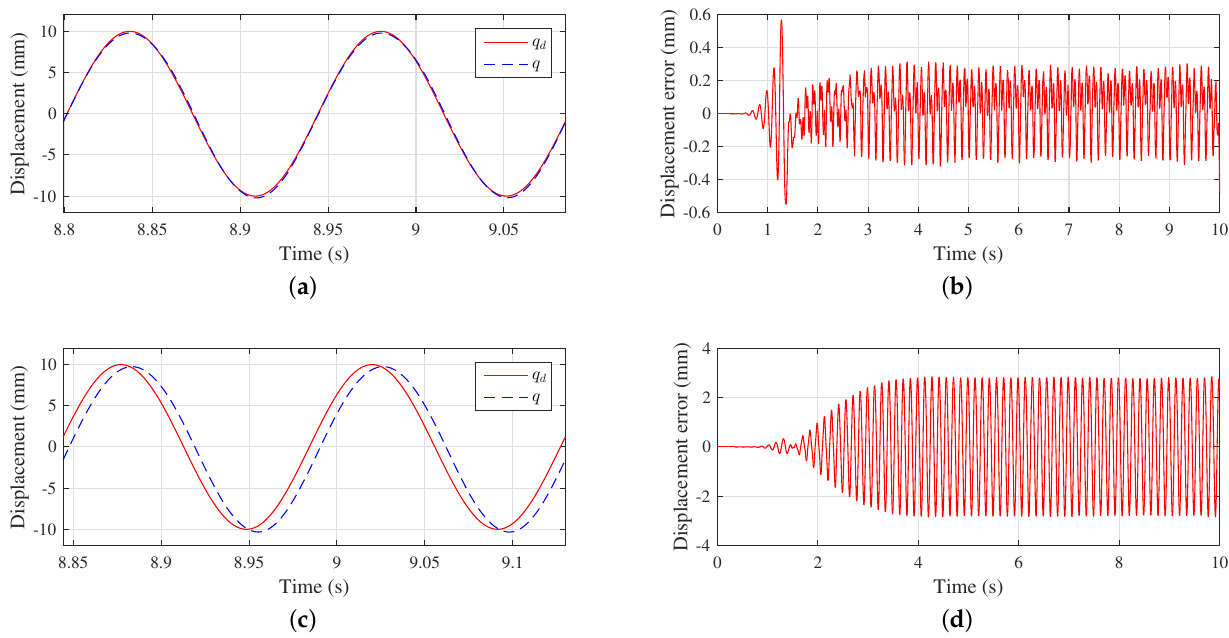
Figure 8. Comparison results at 7 Hz. ( a ) Trajectory tracking of σ -CAC; ( b ) position error of σ -CAC; ( c ) trajectory tracking of TAC; ( d ) position error of